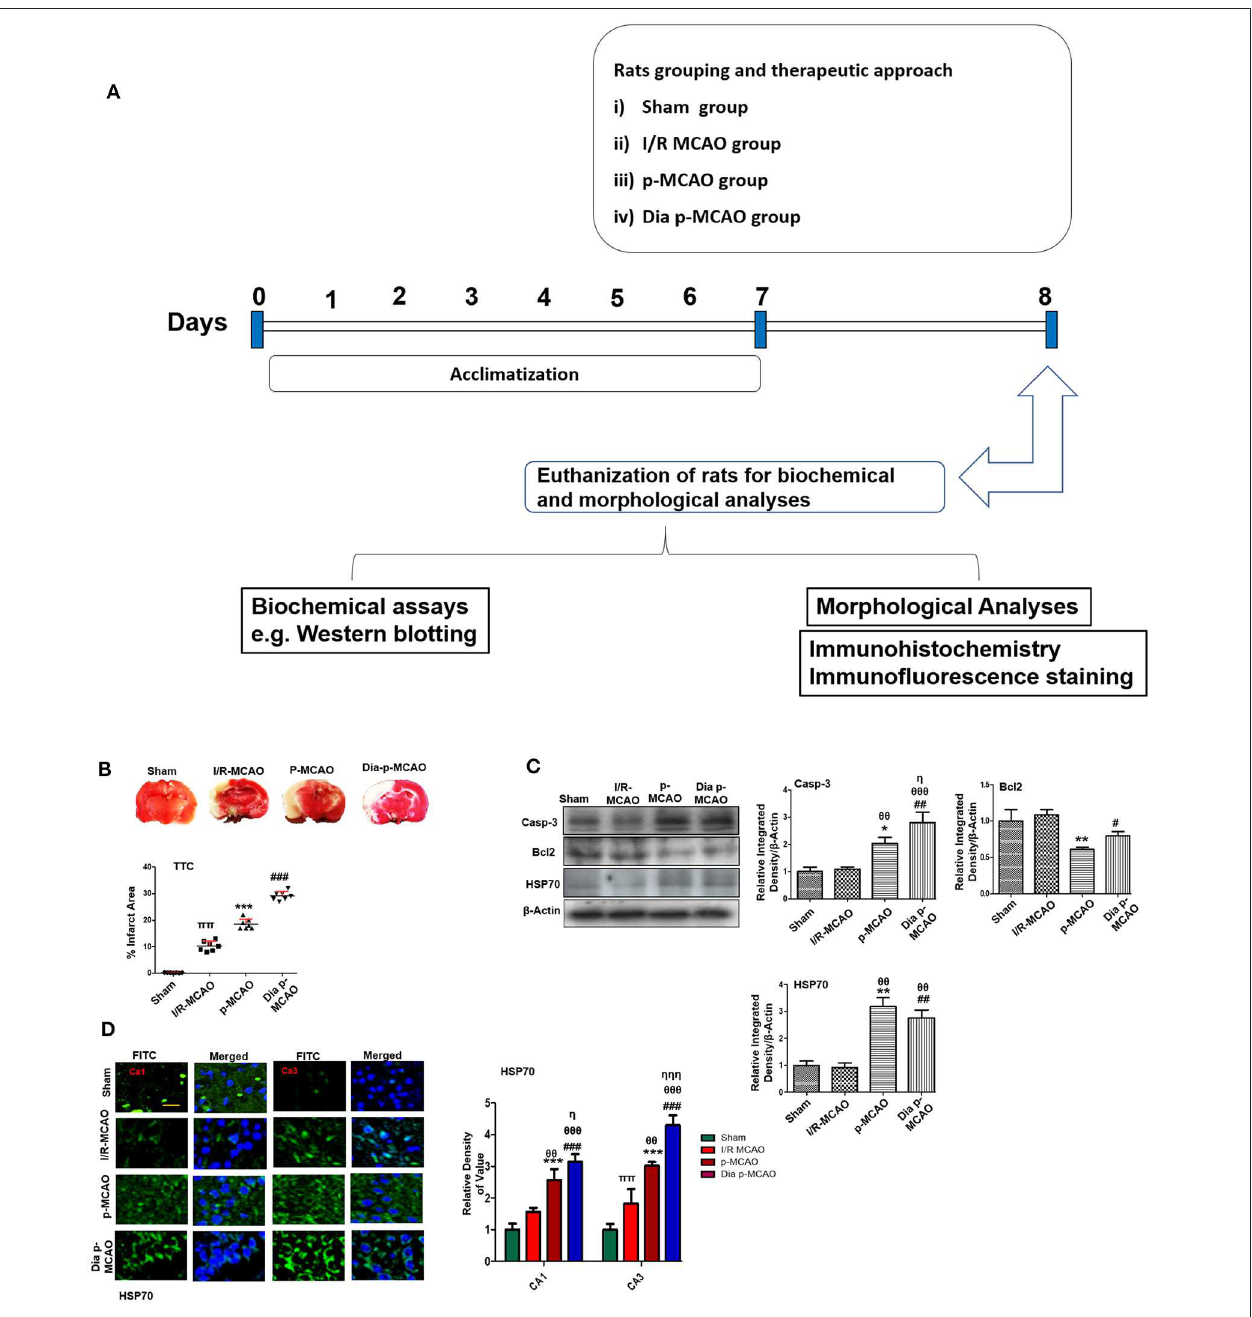
FIGURE 1 | Relative effect of ischemia on brain infarction and cell apoptosis (A) Flow chart of experiment. (B) Brain coronal sections were stained with TTC, which distinguishes between ischemic and non-ischemic areas, one ways ANOVA followed by post-hoc bonferroni multiple comparison test using graph-pad prism-5 software ( n = 7/group). * p < 0.05, # p < 0.05, and π p < 0.05 relative to sham group. (C) Western blot analysis of Casp-3, Bcl2, HSP70. Densitometric analysis was expressed in relative to β -Actin ( n = 5/group). * p < 0.05 and # p < 0.05 relative to sham group, θ p < 0.05 relative to I/R MCAO, η p < 0.05 between p-MCAO and Dia p-MCAO. θθ shows significant difference of p-MCAO and Dia p-MCAO to I/R, and its value is p < 0.01, θθθ shows significant difference of p-MCAO and Dia p-MCAO to I/R, and its value is p < 0.001, ππ shows significant difference of I/R MCAO to sham, and its value is p < 0.01, ηηη shows significant difference between p-MCAO and Dia p-MCAO, and its value is p < 0.001. (D) Representative images of HSP70 immunofluorescence staining in CA1 and CA3 region of hippocampus ( n = 5/group). Scale bar = 100 µ m. * p < 0.05 and # p < 0.05 relative to sham group, θ p < 0.05 relative to I/R MCAO, η p < 0.05 between p-MCAO and Dia p-MCAO. ** p < 0.01, *** p < 0.001, ## p < 0.01, and ### p < 0.001.